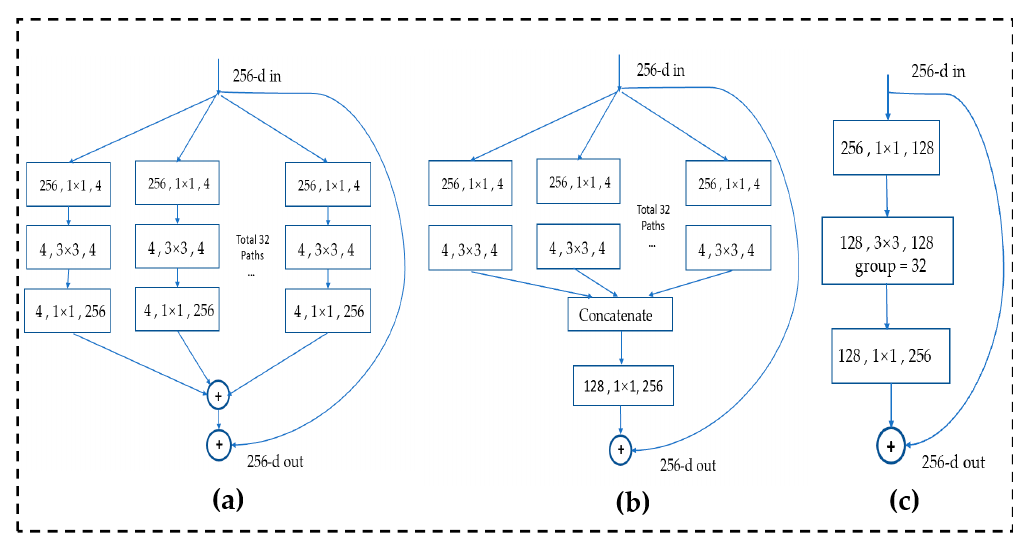
Figure 4. Structure of ResNext, ( a – c ) are the equivalent structure which use the grouped convolutions(cited form ResNext paper, we use structure c in our model) [35].